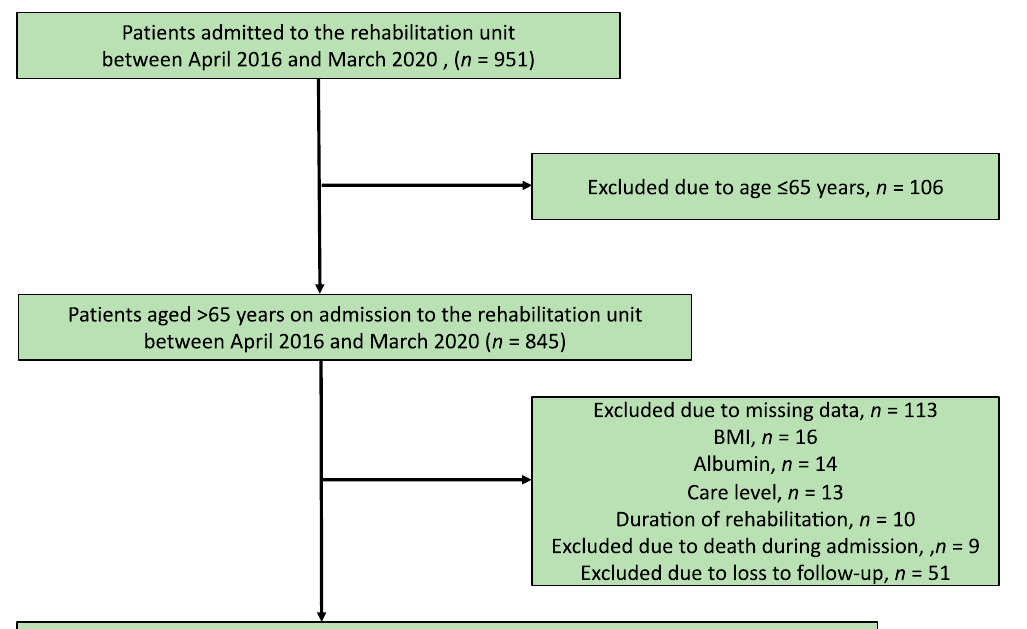
Figure 1. Patient inclusion flowchart.